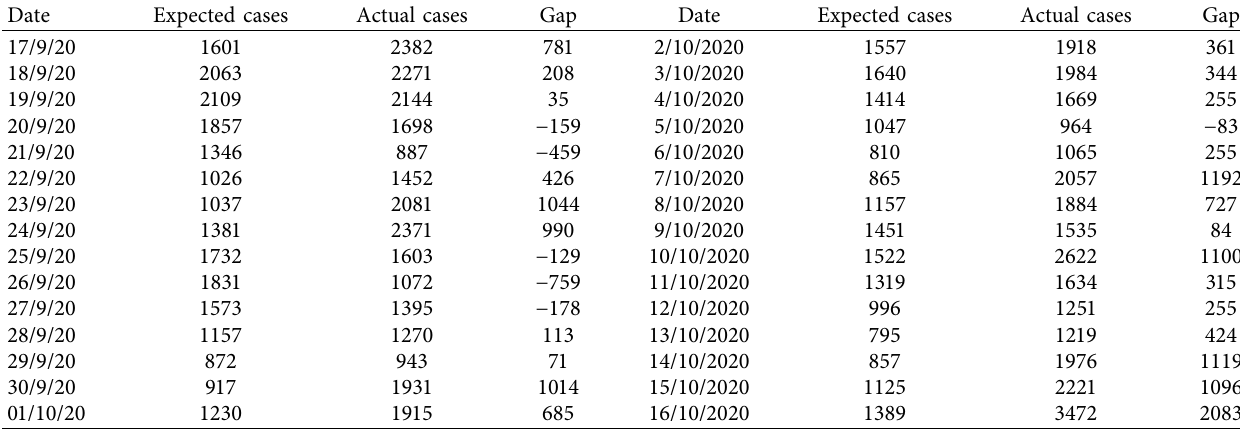
Table 14: The deviation between the actual and forecasted values of the daily confirmed COVID-19 cases in Southern Africa for the period between